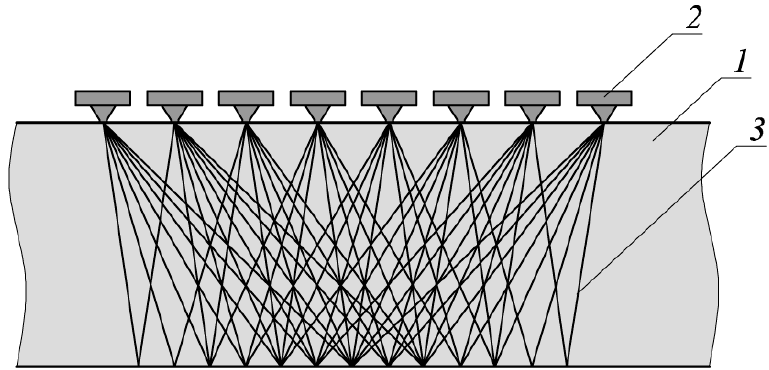
Figure 3. Applied measuring equipment, ( a ) electromagnetic scanner - PS 200, ( b ) ultrasonic tomography - Pundit 250 Array, ( c ) radar scanner - GPR Live.